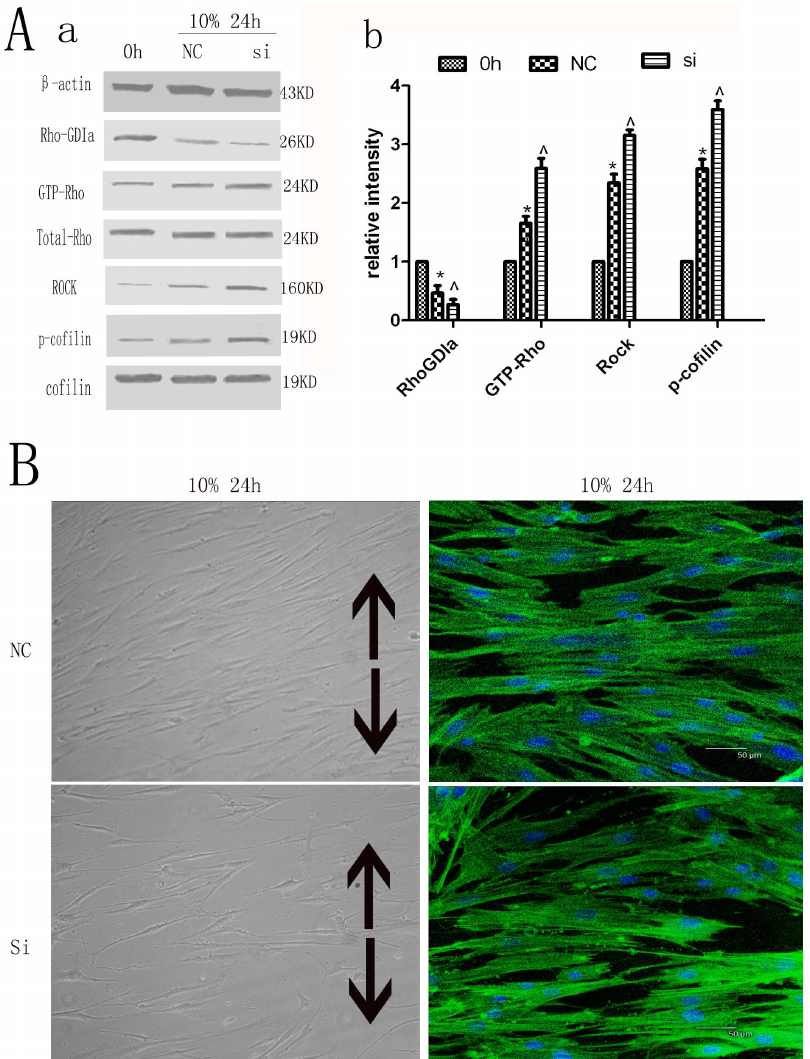
Figure 3. Silencing of Rho-GDP dissociation inhibitor alpha and its effect on the expression of Rho signaling pathway proteins. Silencing of Rho-GDP dissociation inhibitor alpha on Rho-GDIa, GTP-Rho, Rock, p-cofilin protein expression. The protein expression levels of Rho-GDIa in the Rho-GDIa siRNA transfection group were significantly less than those in the negative control (NC) group, while the expressions of GTP-Rho, Rock and phospho-cofilin were increased compared to the NC group. Values shown are the mean 6 SD for each group from three independent experiments. * p , 0.05 vs. control group, ‘ p , 0.05 vs. NC group. All the band intensities are firstly normalized to the loading controls then normalized to the 0h treatment and loading control ratio. (B) Effects on cell morphology and cytoskeletal rearrangement by cytoskeleton staining.